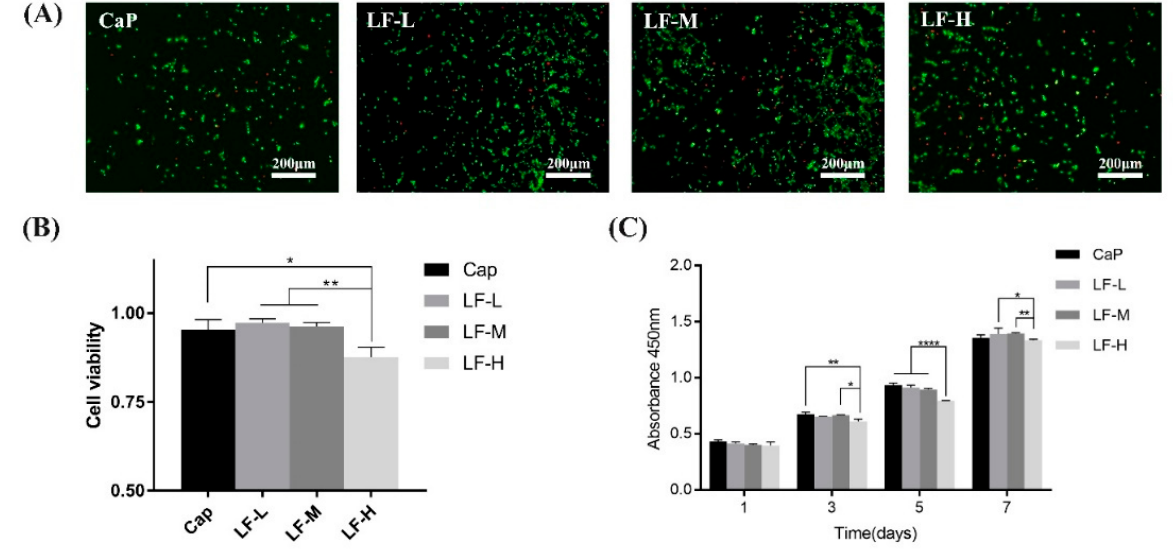
Figure 9. ( A ) Fluorescence microscopy images of live/dead cells (green: live, red: dead) of BMSCs after seeding on CaP, LF-L, LF-M, and LF-H for 3 days; ( B ) cell viability quantitative analysis according to the live/dead cell numbers; ( C ) the absorbance of live cells after 1, 3, 5, and 7 days of culture using the CCK-8 assay kit; * p < 0.05, ** p < 0.01, *** p < 0.001, **** p < 0.0001.